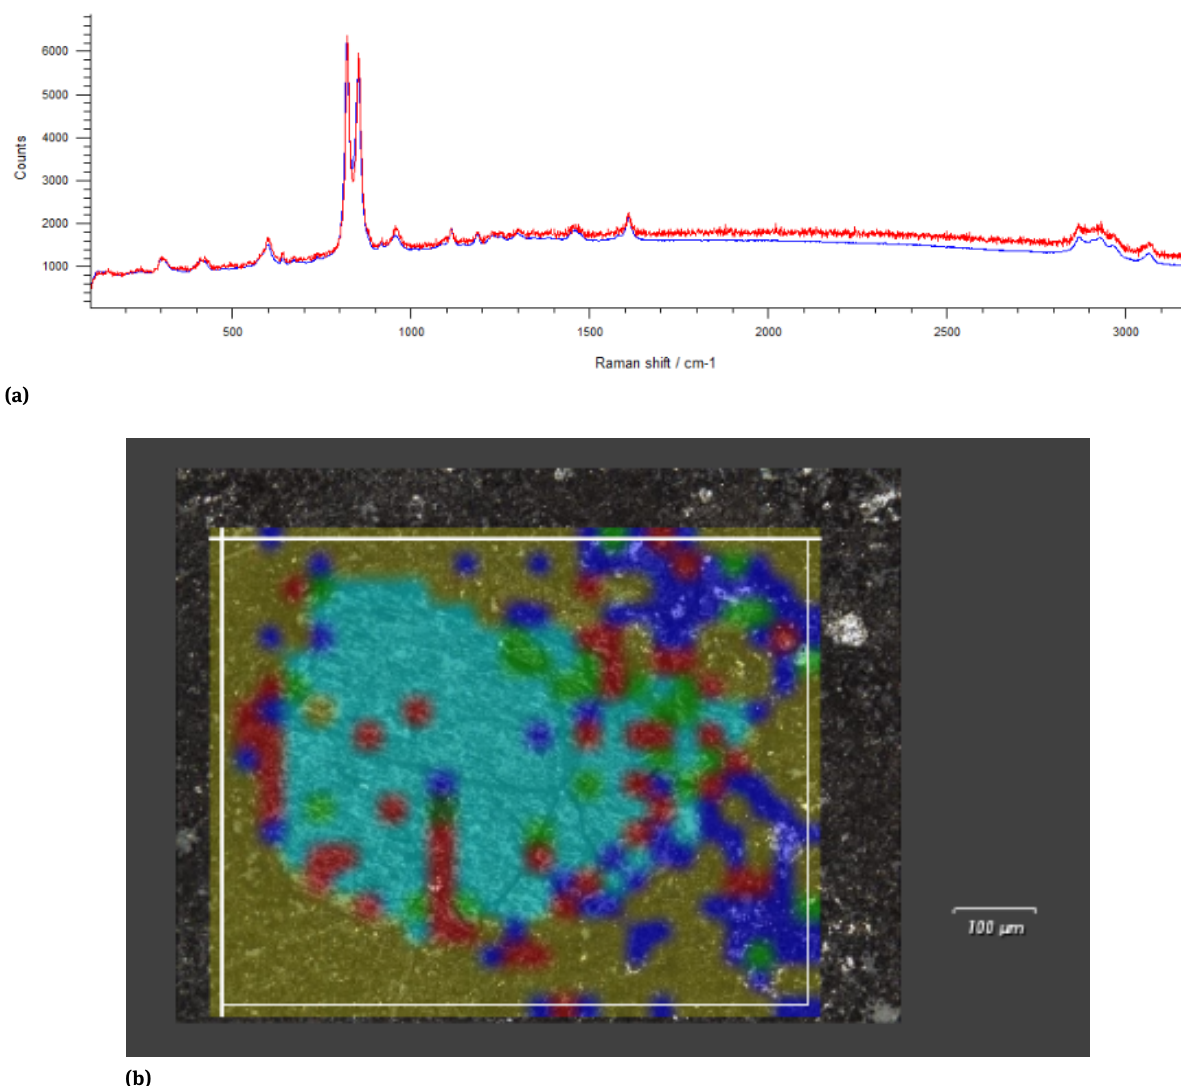
Figure 2. (a) Raman spectrum of the Kaba meteorite shows well-pronounced peaks of olivine; (b) 2D Raman mapping image of an olivine grain showing the forsteritic olivine (pale blue), sulphides (green), graphite (blue) and the metals (red) set into the carbonaceous